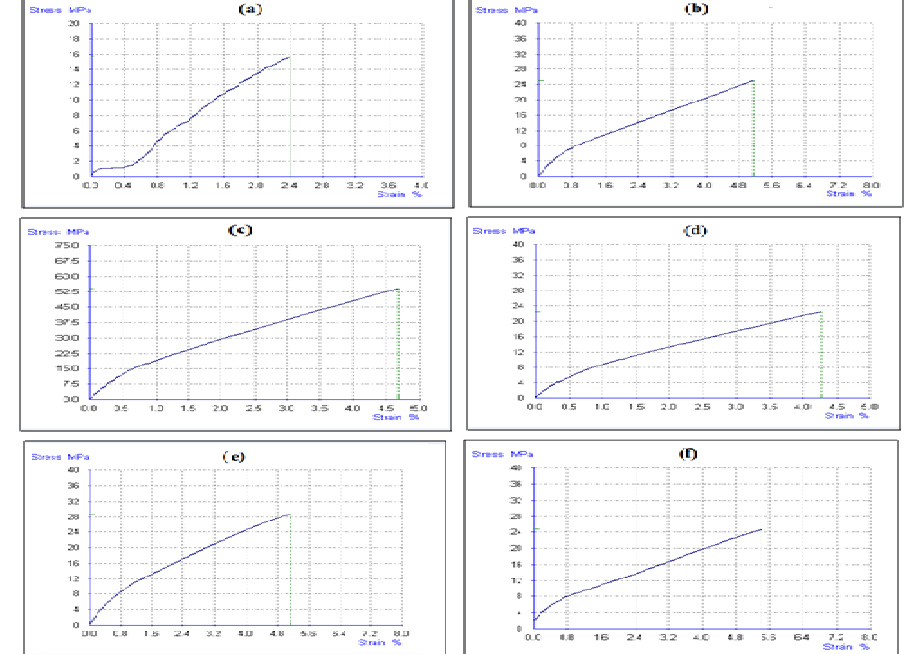
Fig.11: (a, b, c, d, e and f) (stress-strain) curves for pure UP and UP/ nano SiO at X= (0, 1, 2, 3, 4 and